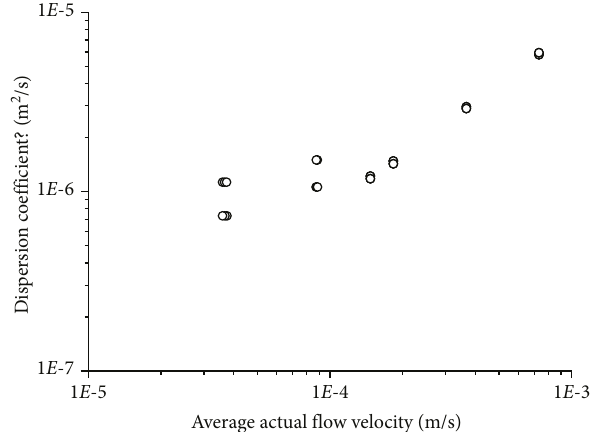
Figure 8: Diagram of relation between dispersion coe ffi cient and average actual fl ow